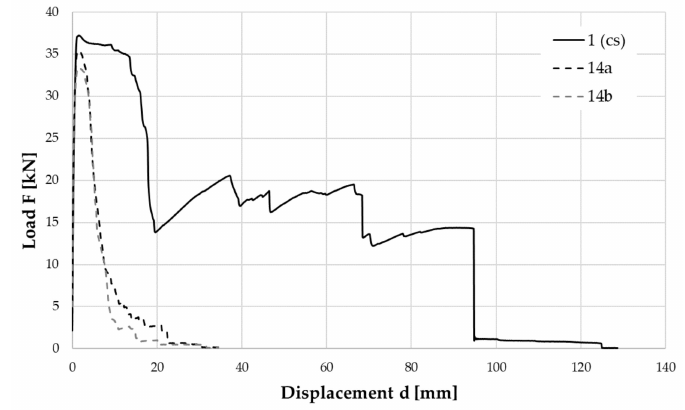
Figure 17. Tensile load-displacement response curves of sample 1 with an external covering layer and samples 14a and 14b without an external covering layer.